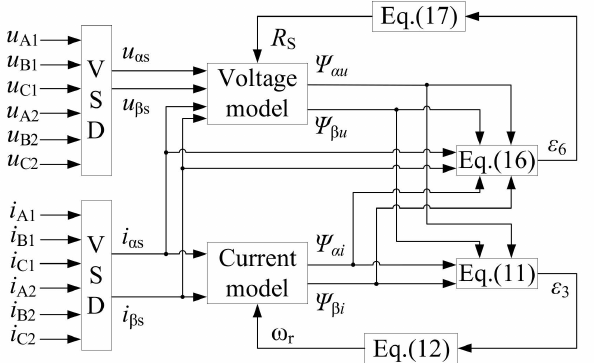
Figure 9. The block diagram of speed-estimation based on VSD with stator resistance